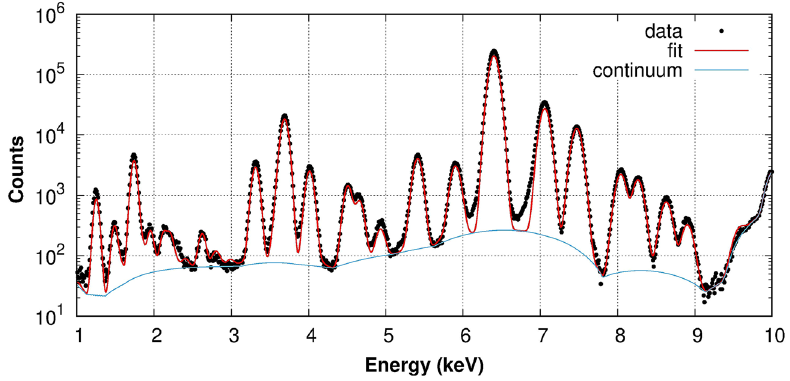
Figure 3. XRF spectrum collected using an incident beam of 10 keV (points) collected over 300 s in a hollow region of coin D, best-fit (thick red line) and continuum baseline used for the fit (thin blue